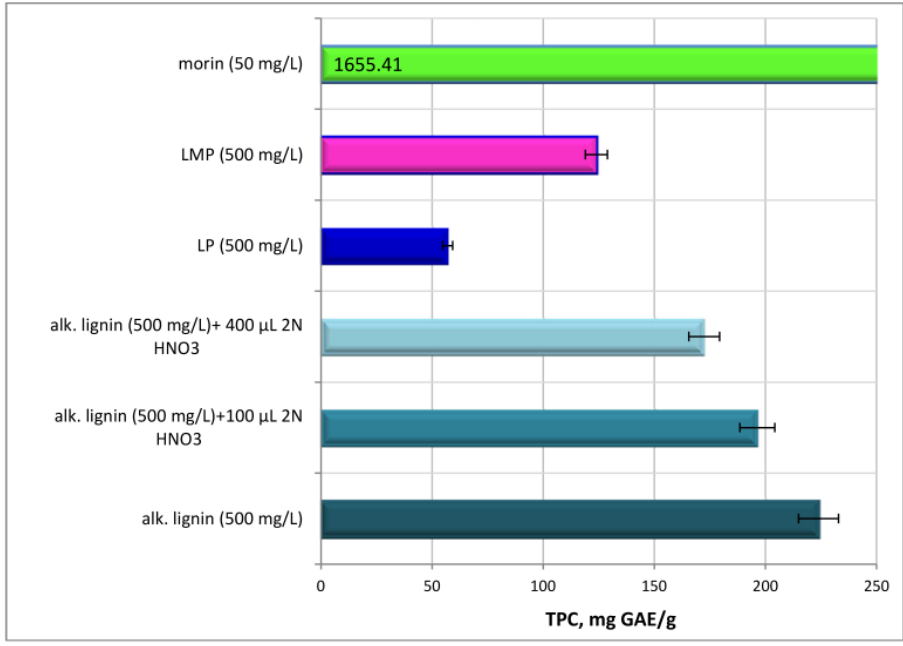
Figure 9. Total phenolic content (TPC) (mg GAE/g) ( ± SD) of LPs, LMPs and pure substances and effect of nitric acid on TPC of alkali lignin.